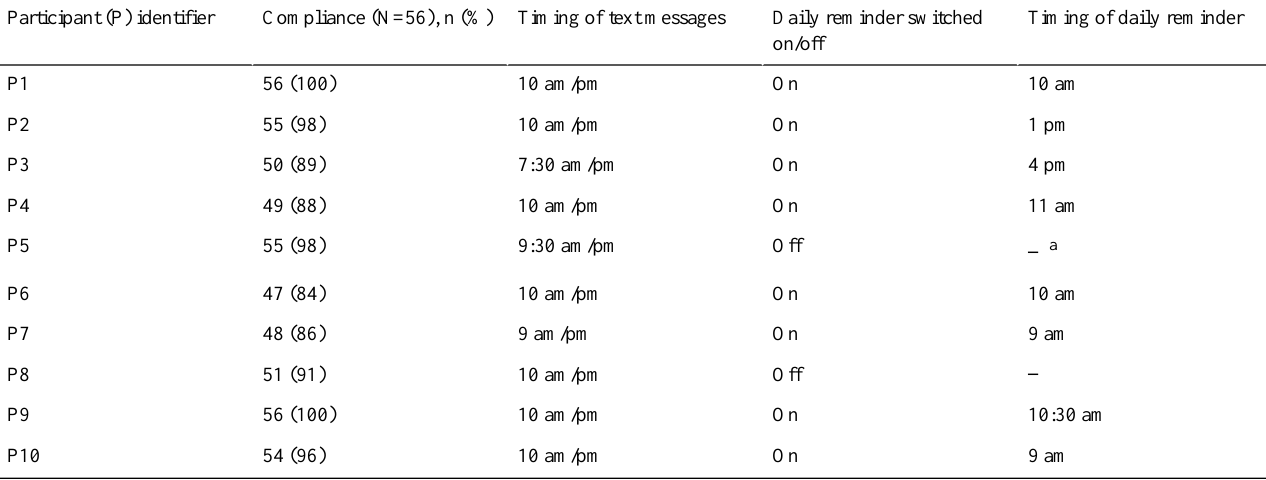
Table 3. Compliance with the twice-daily ecological momentary assessments.